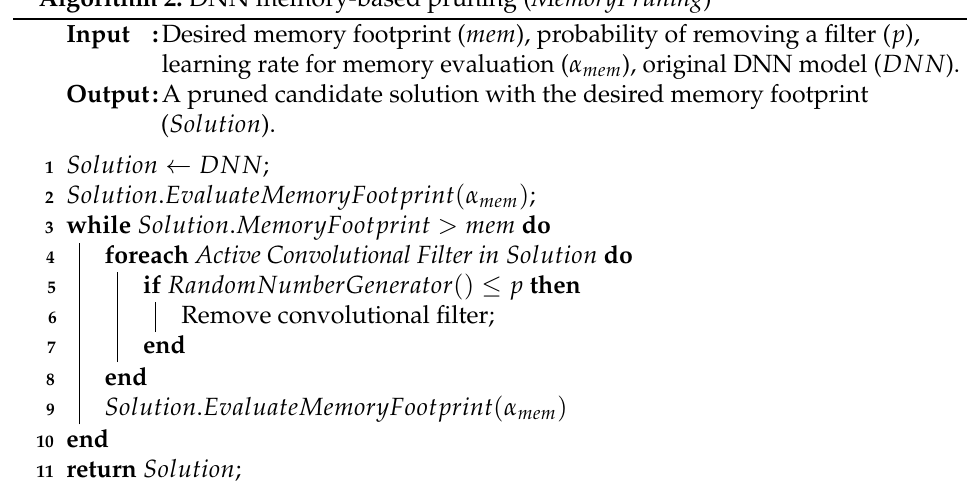
Algorithm 2: DNN memory-based pruning ( MemoryPruning